Question: Judging by this figure, is the value going up or going down?
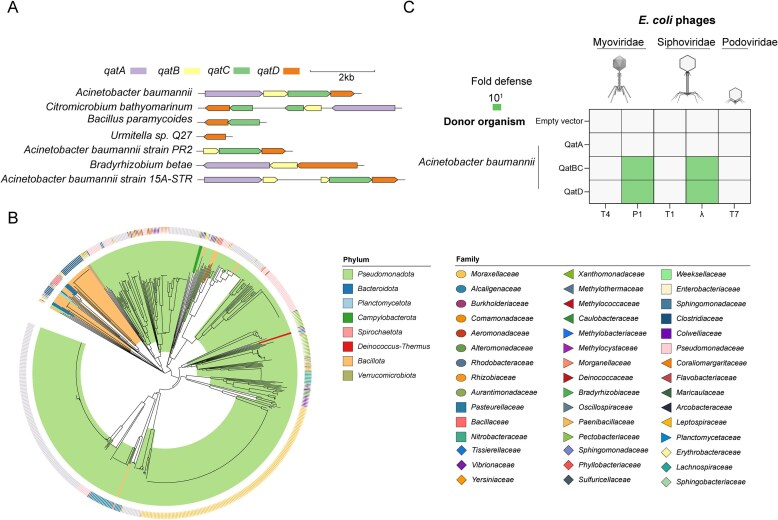
Answer: increasing